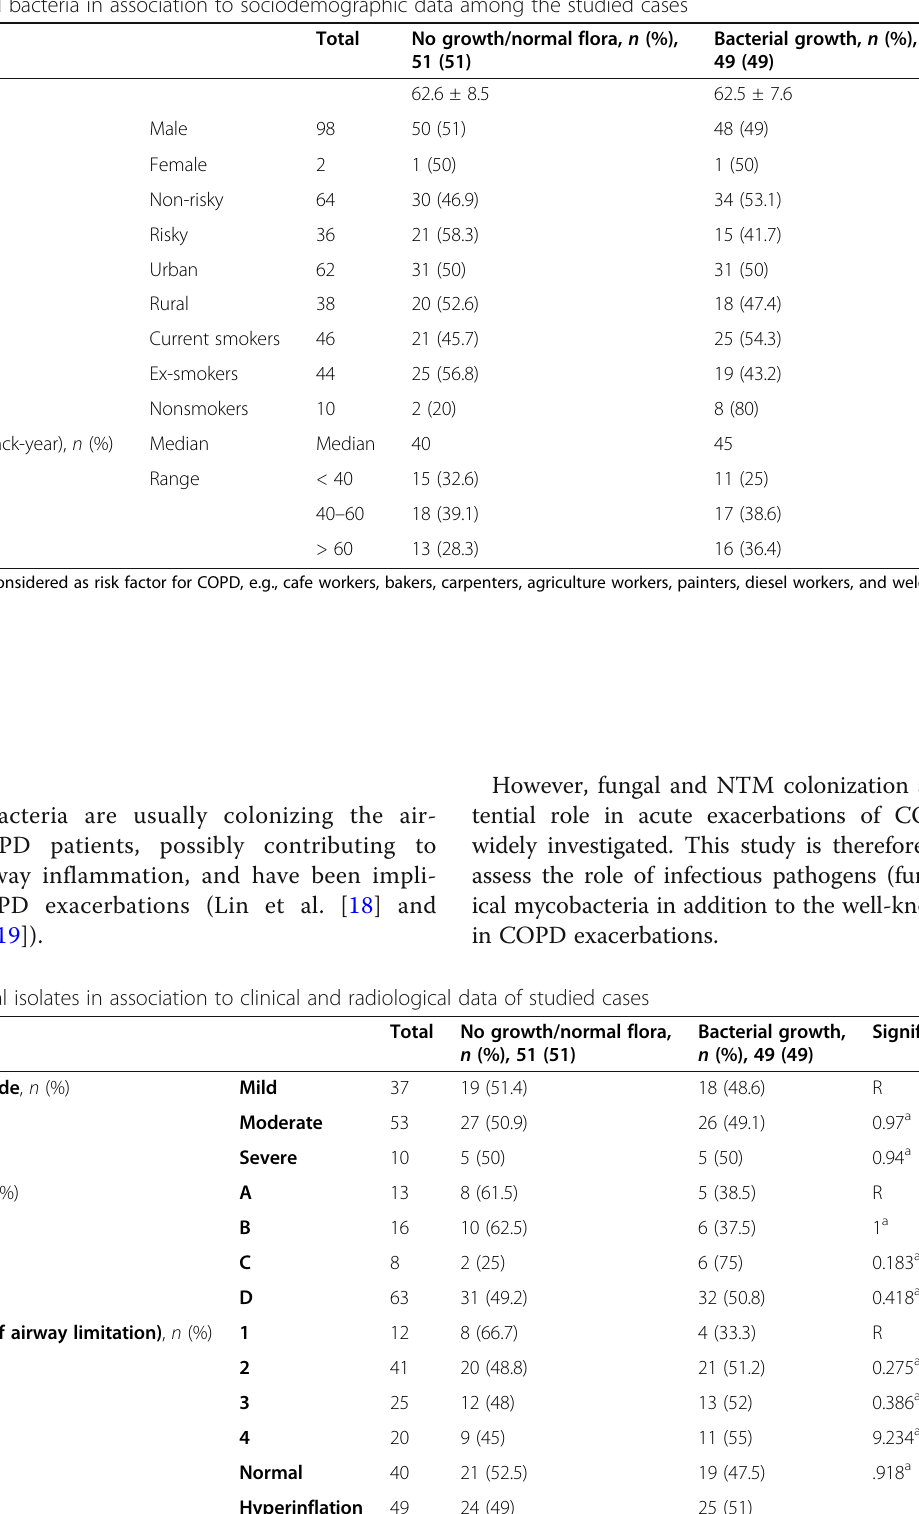
Table 4 Isolated bacteria in association to sociodemographic data among the studied cases Parameter